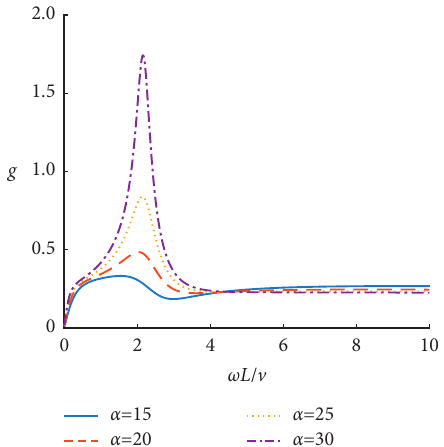
Figure 6: Influence of the parameter α on the equivalent couple amplification factor at the midpoint of the beam.